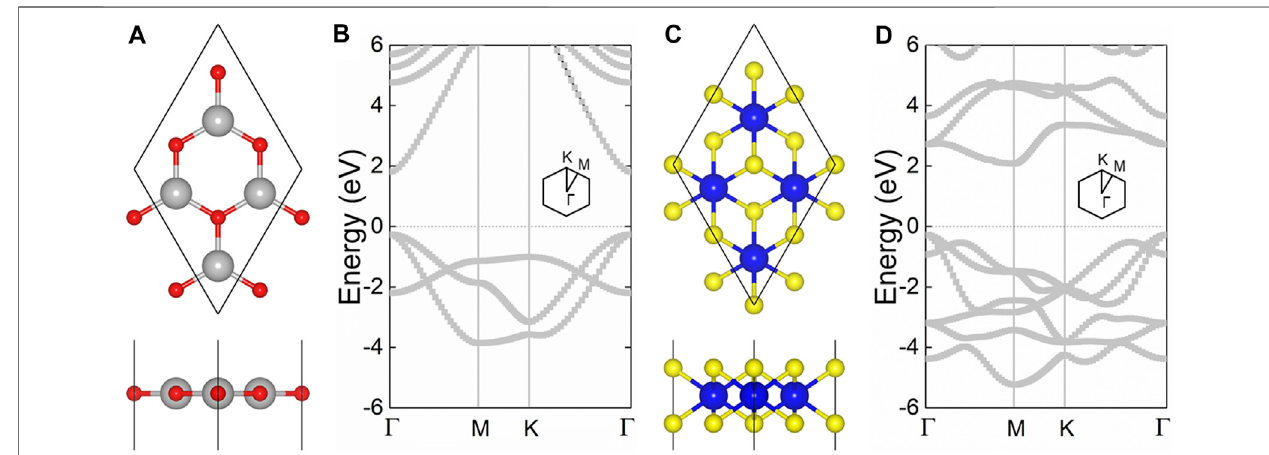
FIGURE 1 | The geometric structures of the (A) CdO and (B) HfS 2 monolayers; the band structures of the (C) CdO and (D) HfS 2 monolayers; grey, red, blue, and yellow balls are Cd, O, Hf, and S atoms, the Fermi level is set to 0.